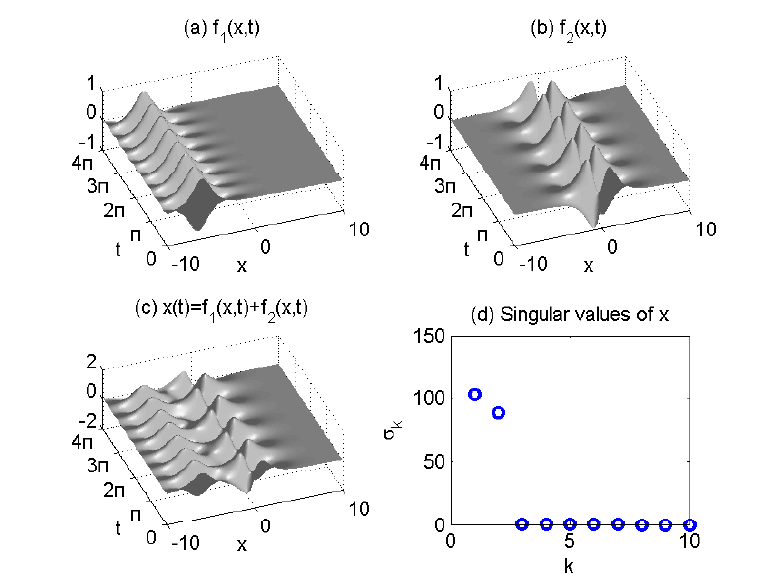
Figure 1. Spatiotemporal dynamics of two signals ( a ) f 1 ( x , t ) , ( b ) f 2 ( x , t ) , and mixed signal in ( c ) x = f 1 + f 2 . Singular values of X are shown in ( d ).